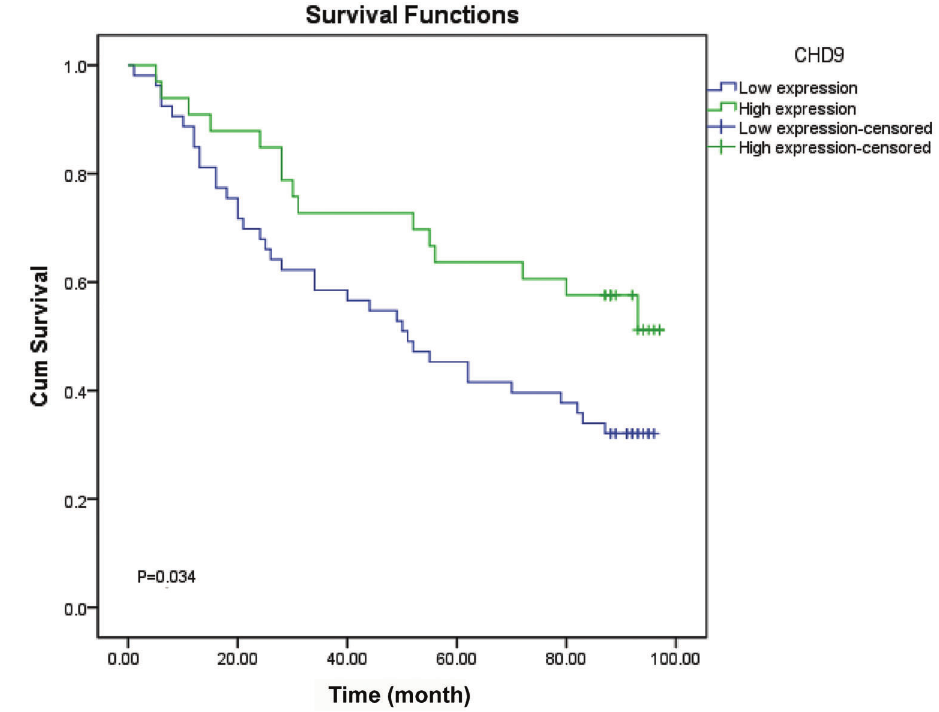
Figure 2. Correlation of CHD 9 expression and the prognosis of colorectal Table 3. COX multivariate regression analysis of the independent predictors of CHD 9 in colorectal cancer patients. Variables B